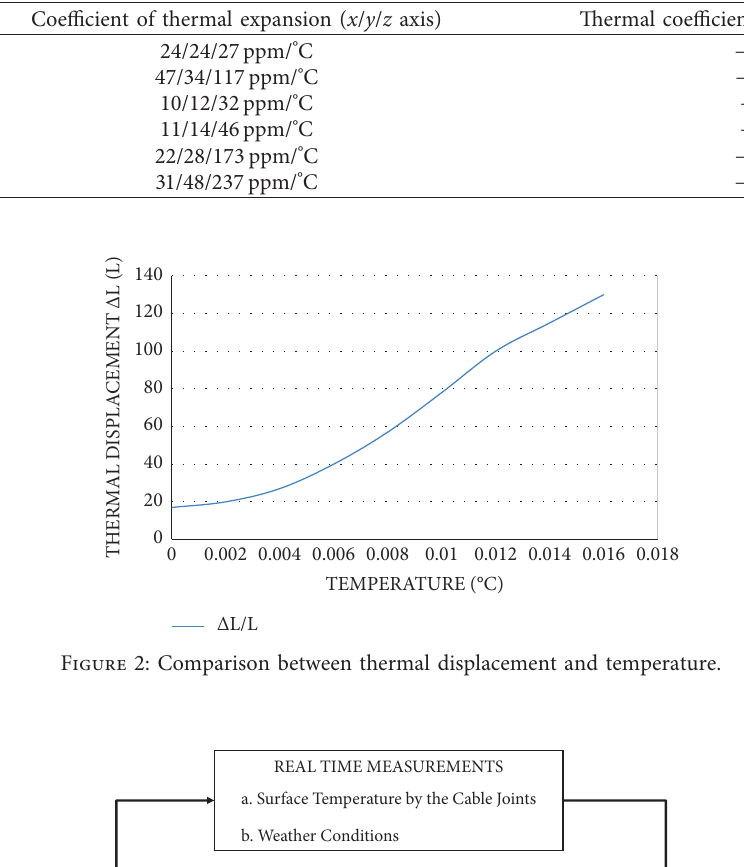
Table 3: Properties of frequently used substrate [12].